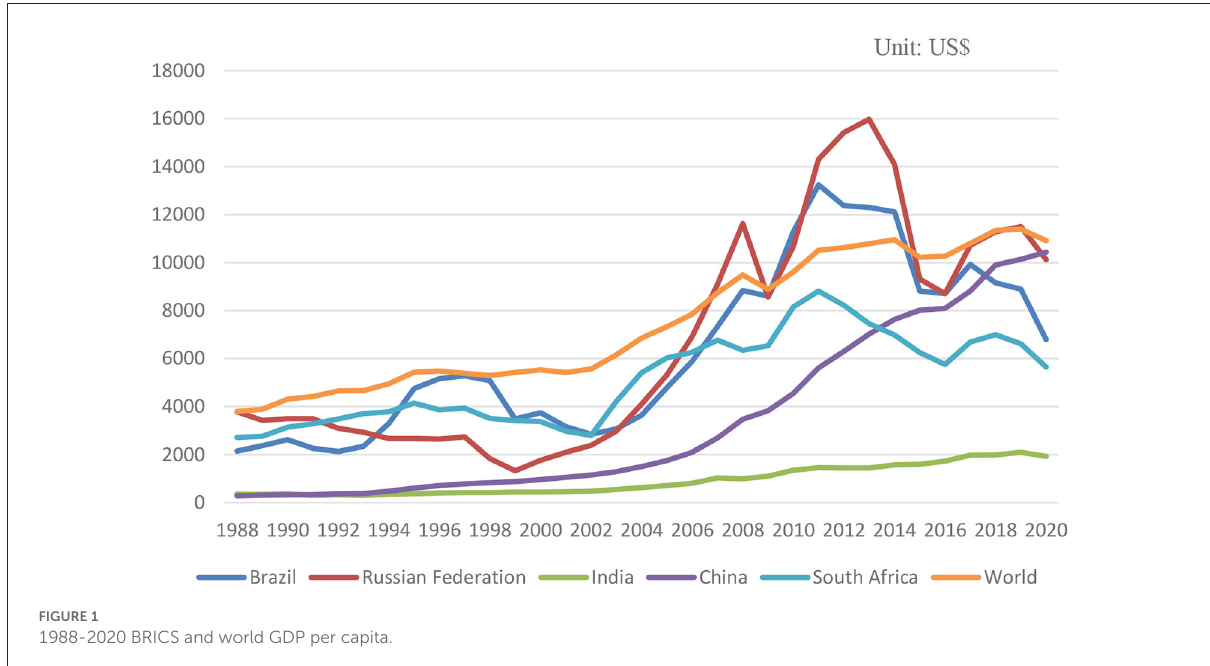
FIGURE1 1988-2020 BRICS and world GDP per